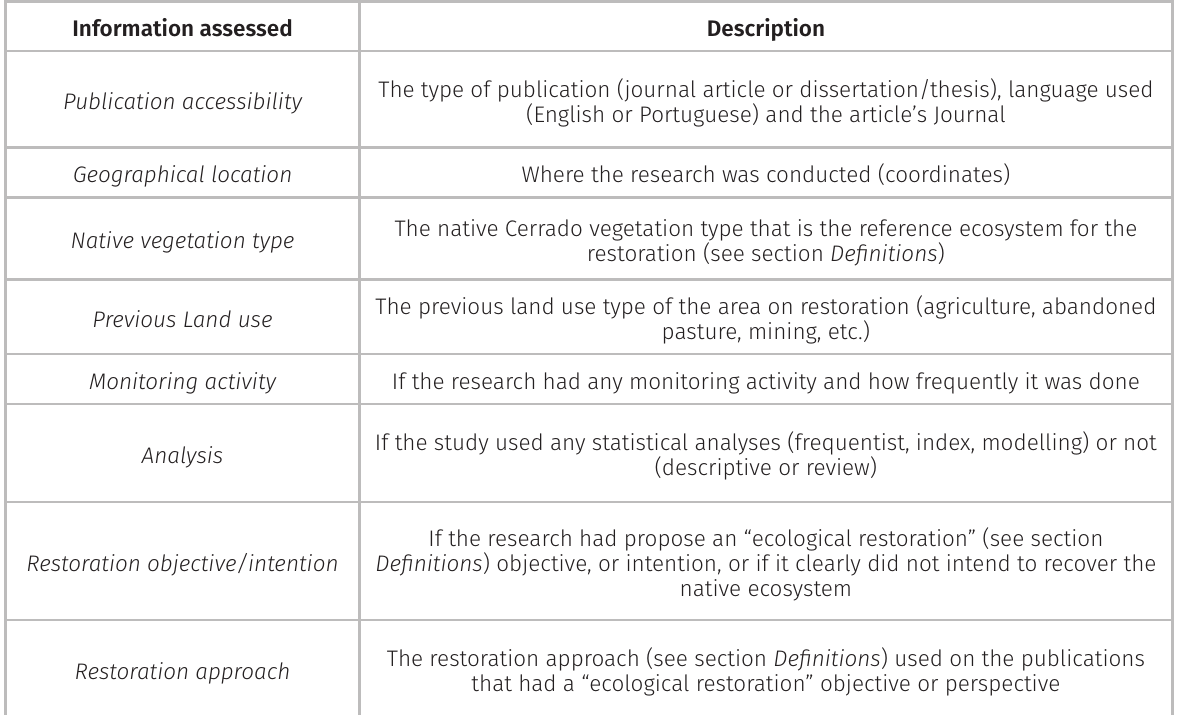
Table II. Information extracted from the selected publications. Information